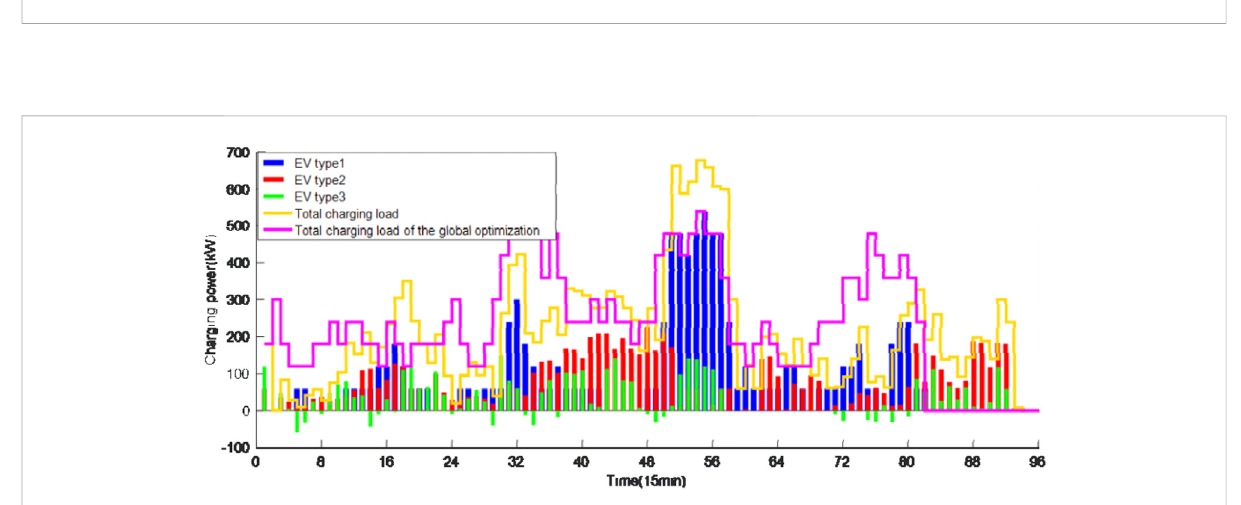
FIGURE 11 Charging power curves of the EVS under different scheduling